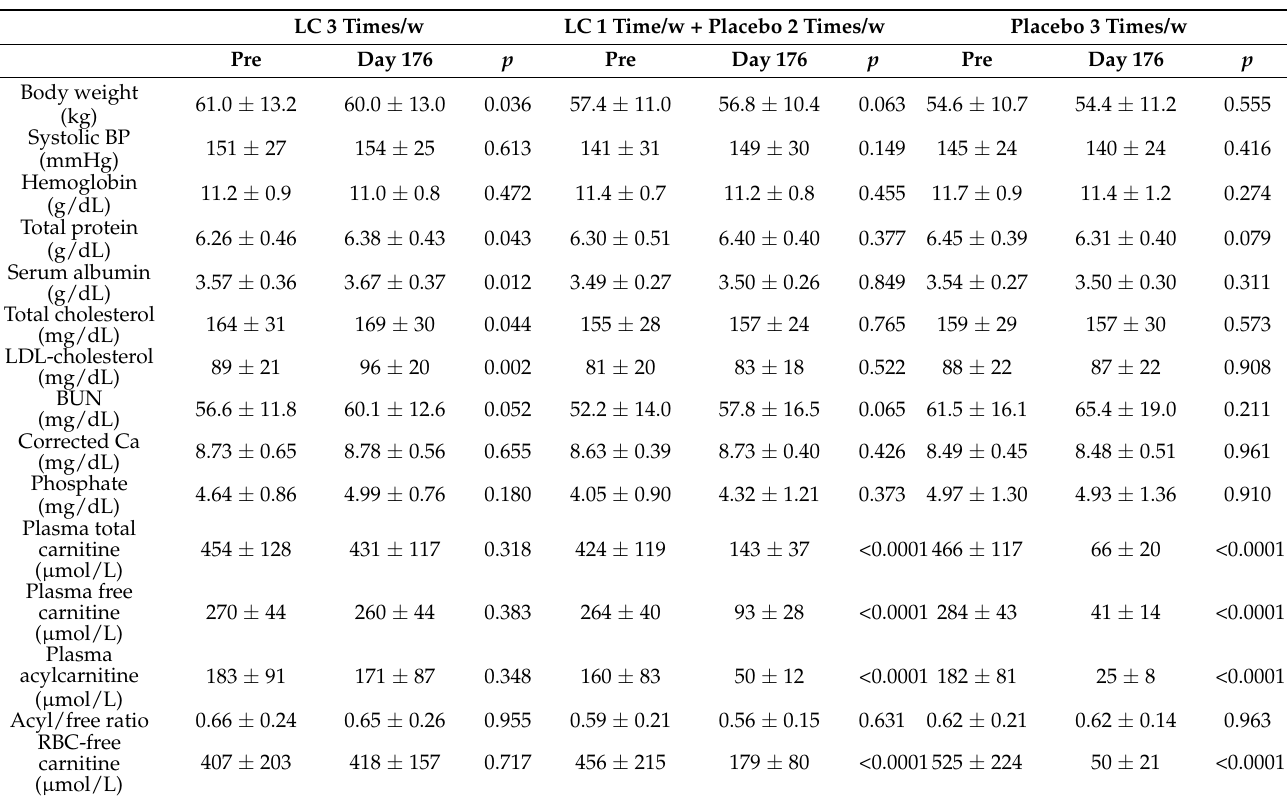
Table 2. Clinical characteristics at baseline and day 176 of the study